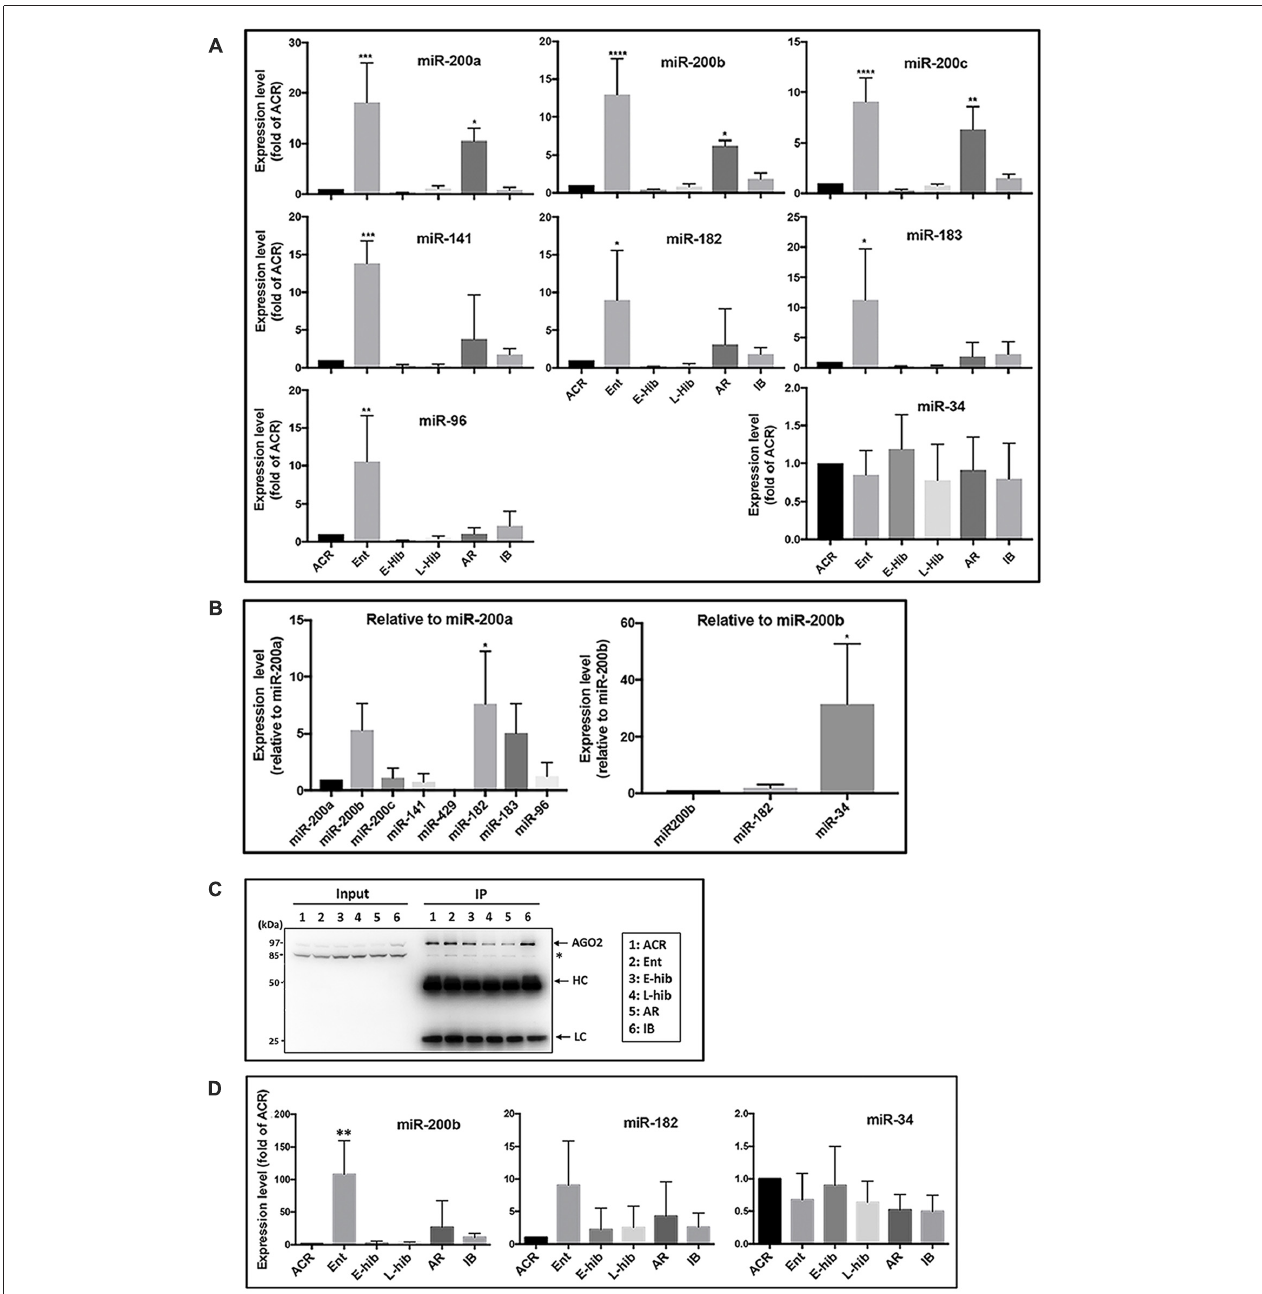
FIGURE 1 | Expressions of miR-200 family and miR-182 cluster members of miRNA are differentially regulated in squirrel brains during hibernation bouts. (A) Expression levels of miR-200 family (miR-200a, b, c and miR-141) and miR-182 cluster (miR-182, miR-183 and miR-96) members in addition to miR-34 in squirrel brains at different stages of hibernation bout. The levels of these miRNAs were measured by qPCR, normalized ( (cid:49) Ct) by the level of miR-124 and/or miR-103 (i.e., stably expressed miRNAs that did not change during hibernation bout), compared to the expression of ACR ( (cid:49)(cid:49) Ct) and showed as fold-changes of ACR (2 − (cid:49)(cid:49) Ct ). (B) Left: comparisons of expression levels of miR-200 family and miR-182 cluster members of miRNAs in squirrel brains from the active phase (ACR), shown as folds vs. miR-200a. Right: comparison of expression level of miR-34 to miR-200/miR-182 family members in the squirrels’ brain from ACR, shown as folds vs. miR-200b. (C) Representative immunoblots of AGO2-immunoprecipitants of squirrel brain samples from various hibernation stages. HC: IgG heavy chain; LC: IgG light chain. (D) miRNA (miR-200b, miR-182 and miR-34) levels in the AGO2-immunoprecipitants of brain samples from various stages of hibernation bout. They were measured by qPCR, normalized ( (cid:49) Ct ) by the level of miR-124, compared to the expression of ACR ( (cid:49)(cid:49) Ct), and showed as fold-changes of ACR (2 − (cid:49)(cid:49) Ct ) as shown in (A) . ACR, active in cold room; Ent, entrance; E-hib, early torpor; L-hib, late torpor; AR, arousal; IB, interbout. Data represent the mean ± SD of at least four different brain samples from each stage of hibernation bout. The statistical analyses were shown relative to the ACR group. ∗ p < 0.05, ∗∗ p < 0.01, ∗∗∗ p < 0.001, ∗∗∗∗ p < 0.0001.